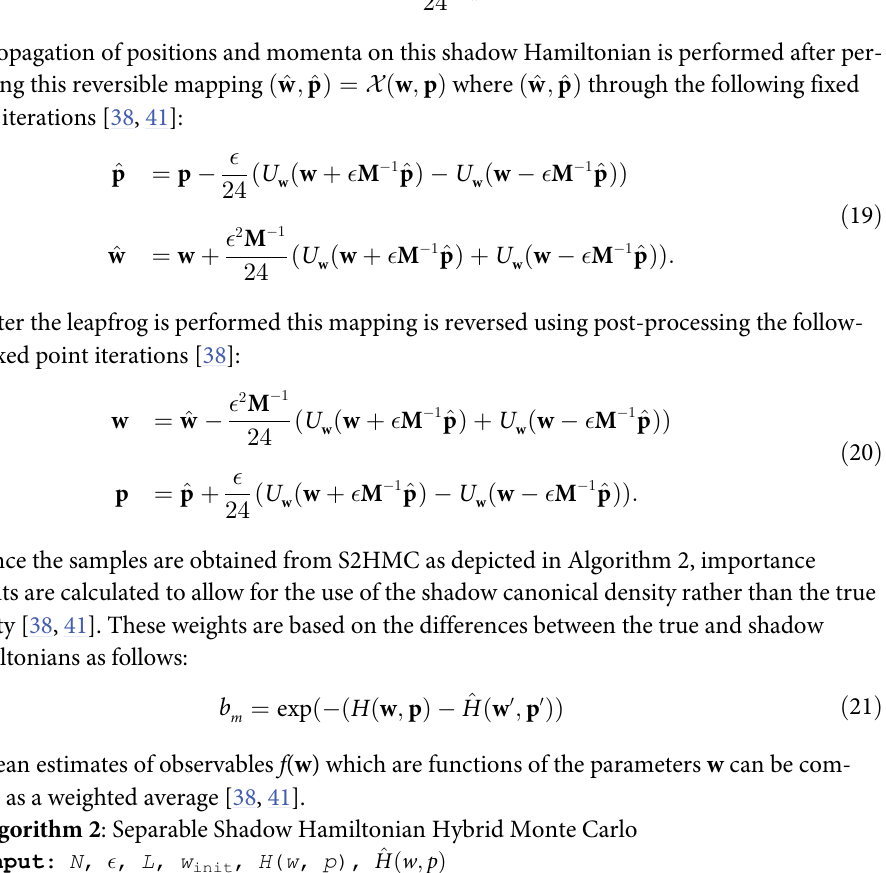
Algorithm 2 : Separable Shadow Hamiltonian Hybrid Monte